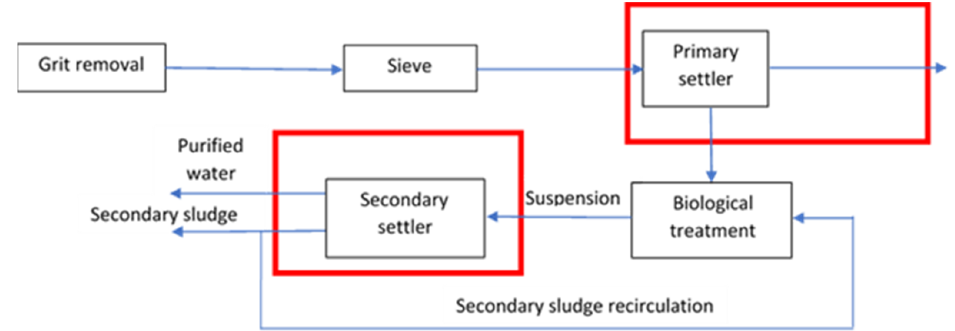
Figure 3. Simplified scheme of WWTP2. Sampling points are marked with red frames.